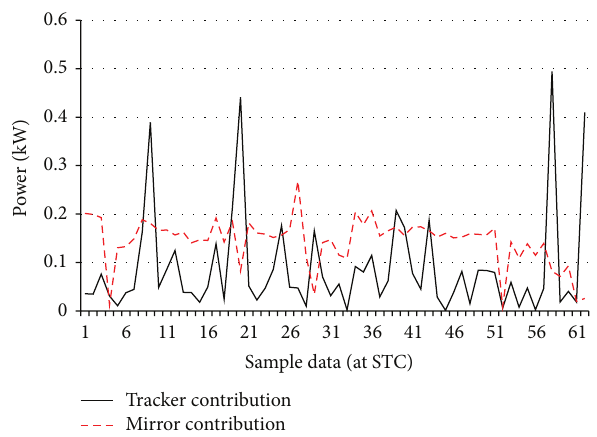
Figure 8: Power generation from mirror concentrator and tracking mechanism at